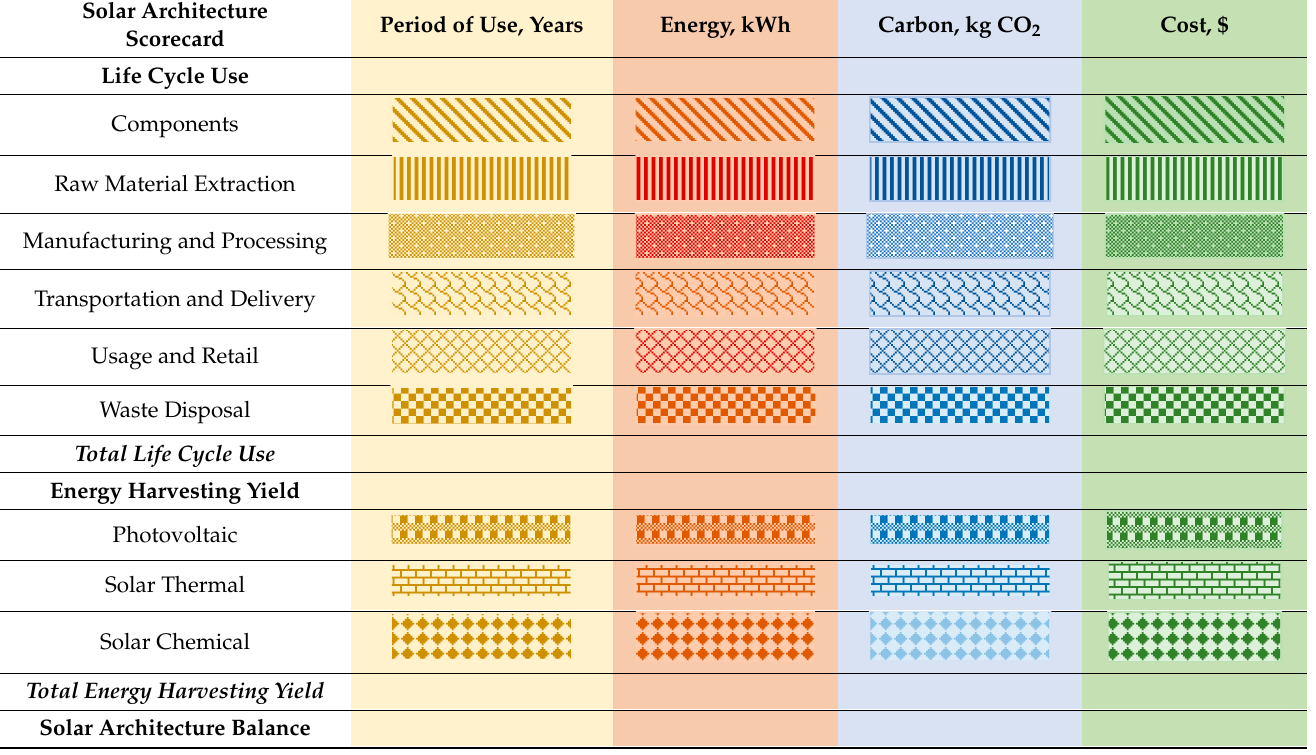
Table 1. Solar Architecture Table template.